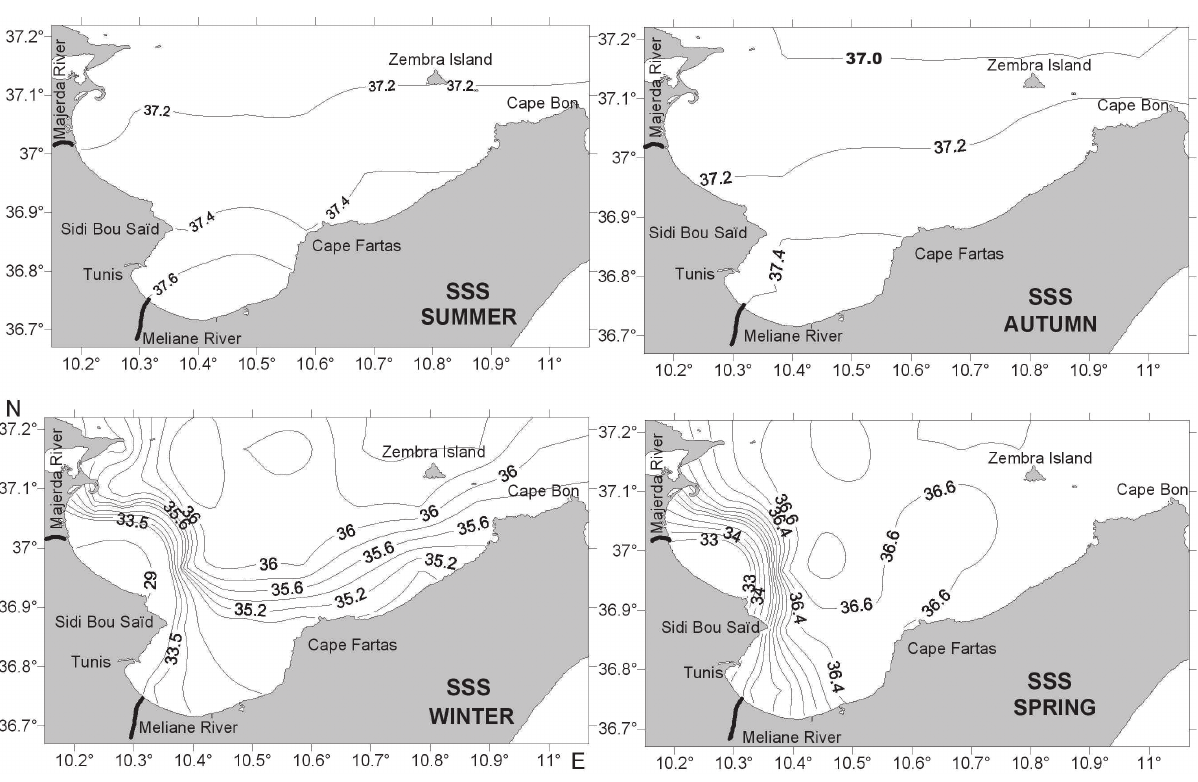
Fig. 3. – sea surface salinity (sss) maps by